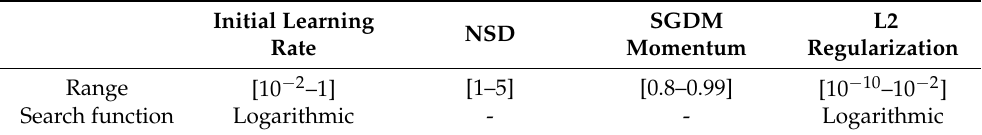
Table 1. Search functions and ranges of optimization variables used during the optimization